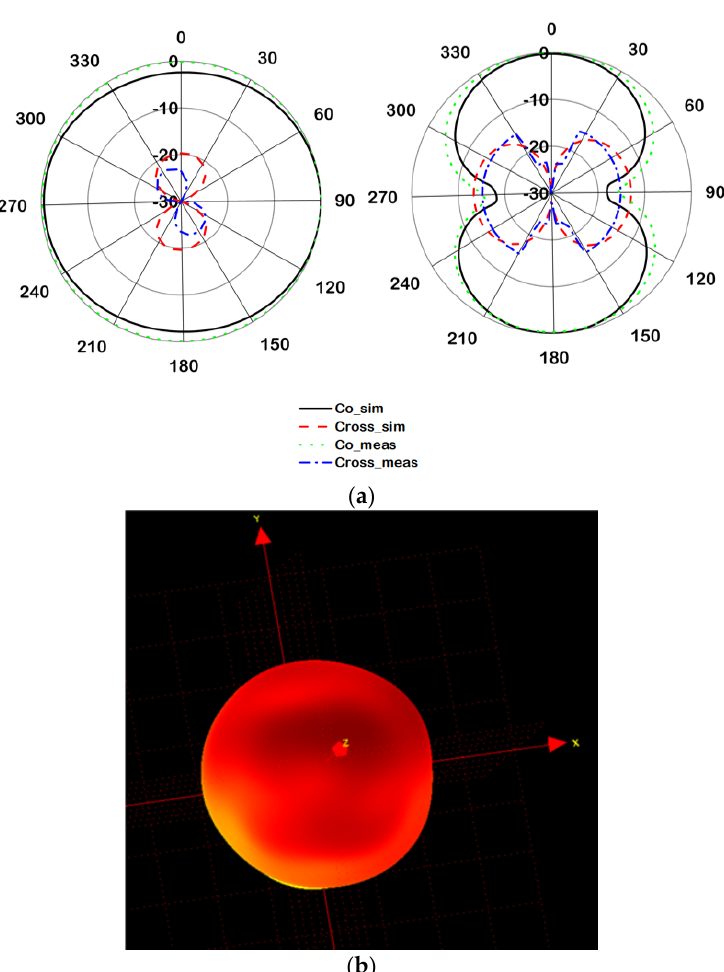
Figure 5. Radiation pattern at 921 MHz ( a ) 2D polar plot and ( b ) 3D pattern.